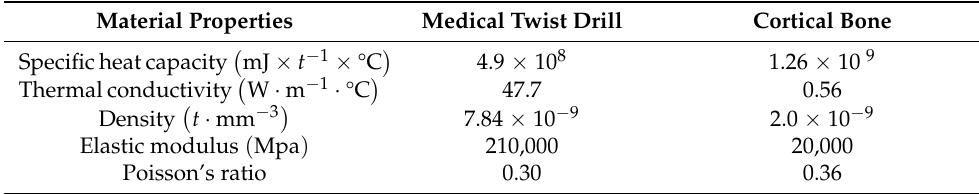
Table 1. Drill bit and bone material